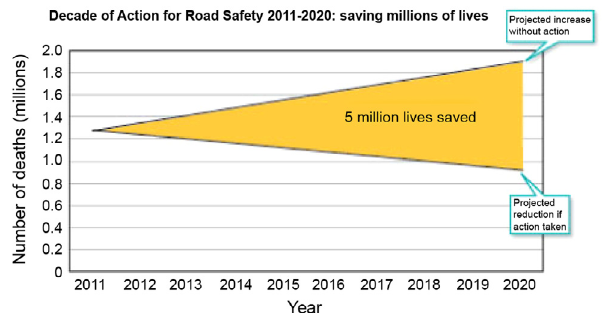
Figure 5. WHO projected trend of road deaths to